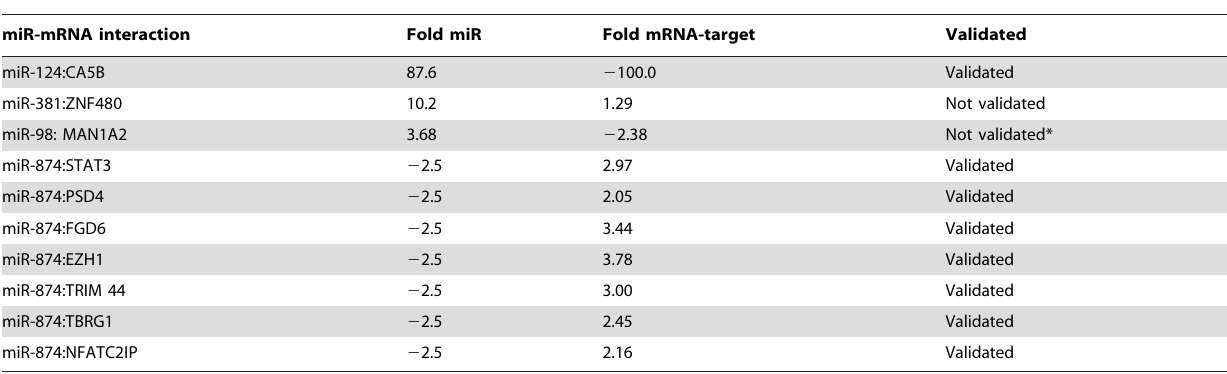
Table 4. MiR-mRNA interactions